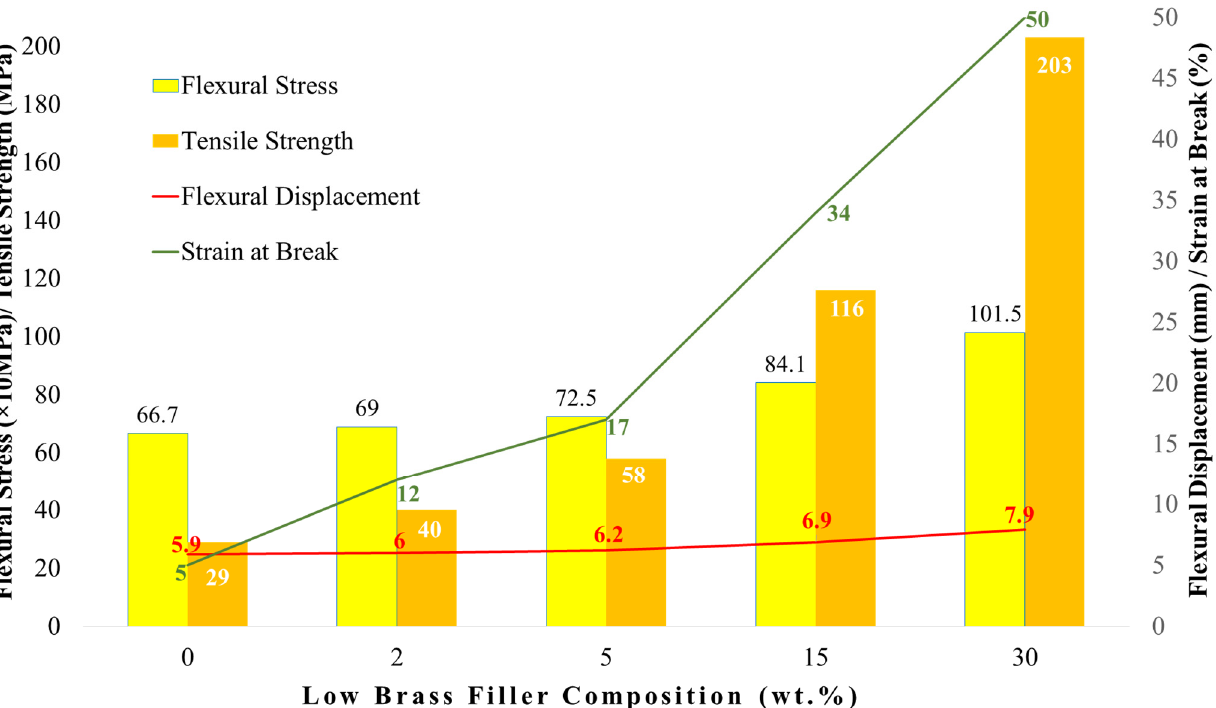
Figure 4. Flexural stress, flexural displacement, tensile strength, and strain at break against various low brass filler composition percentages. low brass filler composition